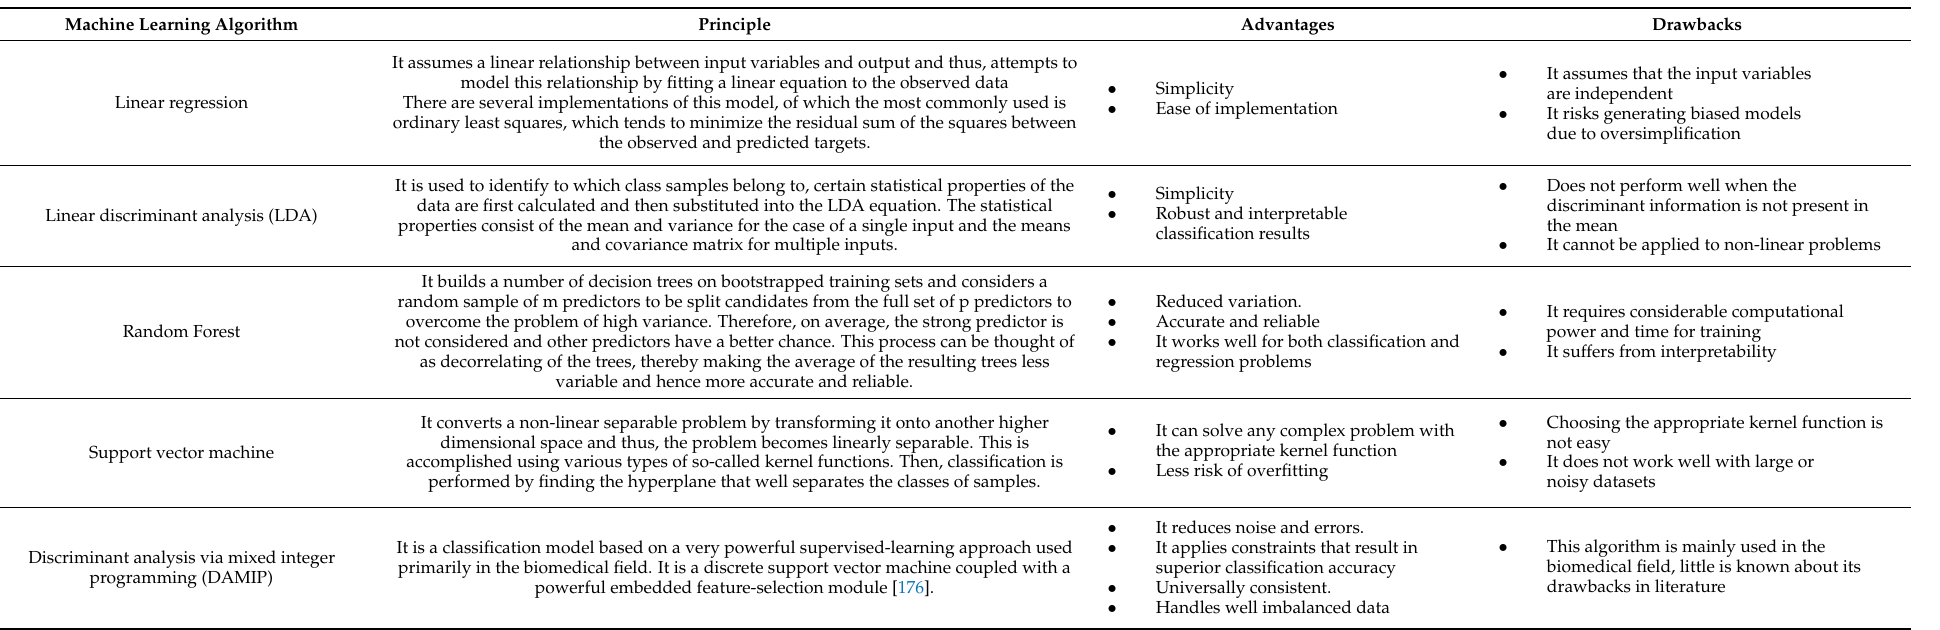
Table 1. Principle, advantages and drawbacks of common machine learning